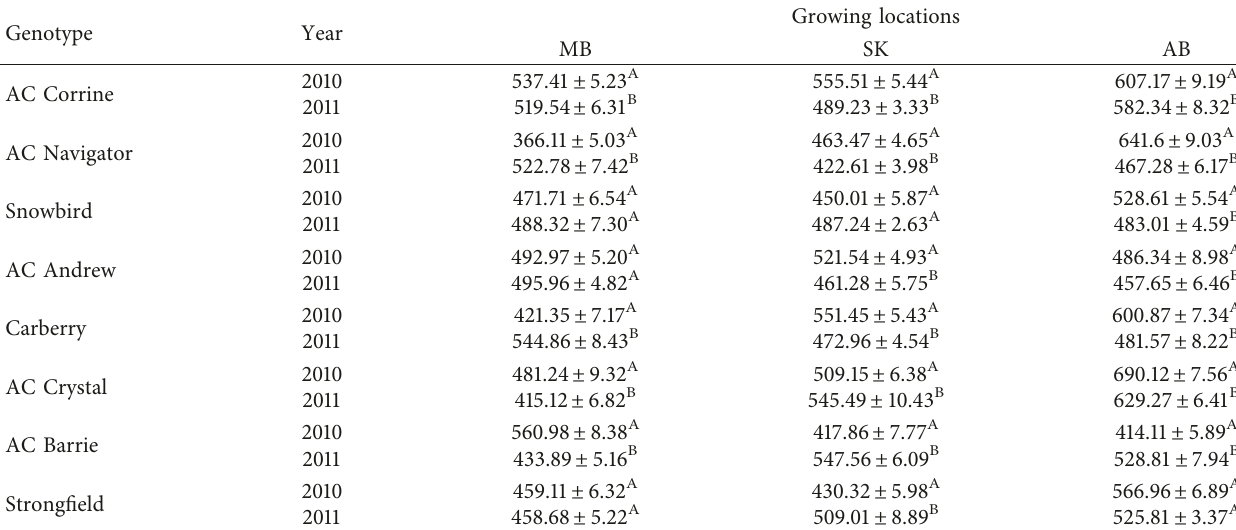
Table 2: Bound phenolic acid contents (microgram per gram of dry matter) in the whole grain of 8 wheat varieties grown in three locations in 2010 and 2011 crop